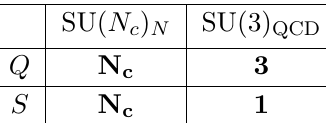
Table 4 . The charge assignment of the vector-like fermions, Q and S , in the composite axion